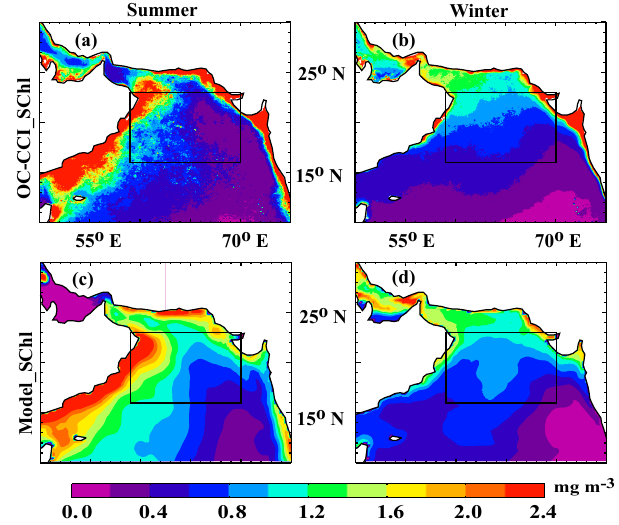
Figure 5. Arabian Sea climatology of (a, c) summer (JJAS) and (b, d) winter (DJFM, a , b ) OC-CCI and (c, d) modelled SChl (mgm − 3 )